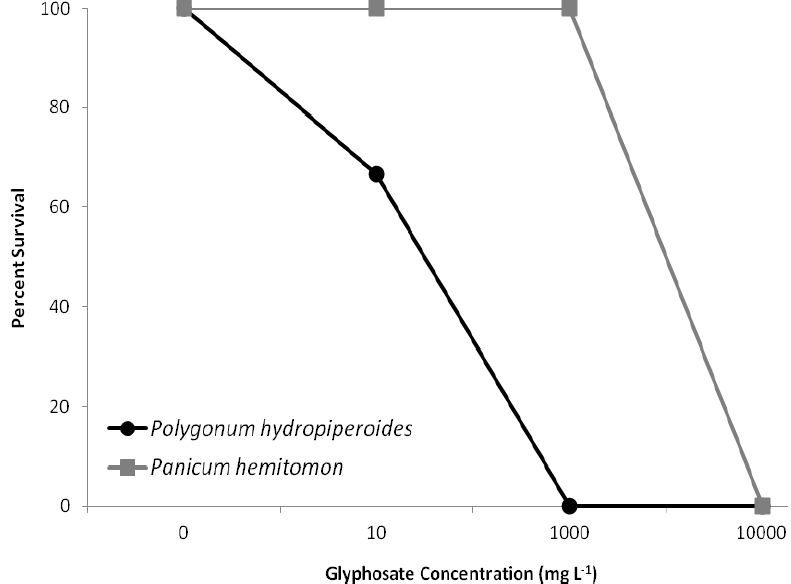
Figure 3. Interactive effects of species and glyphosate concentration on